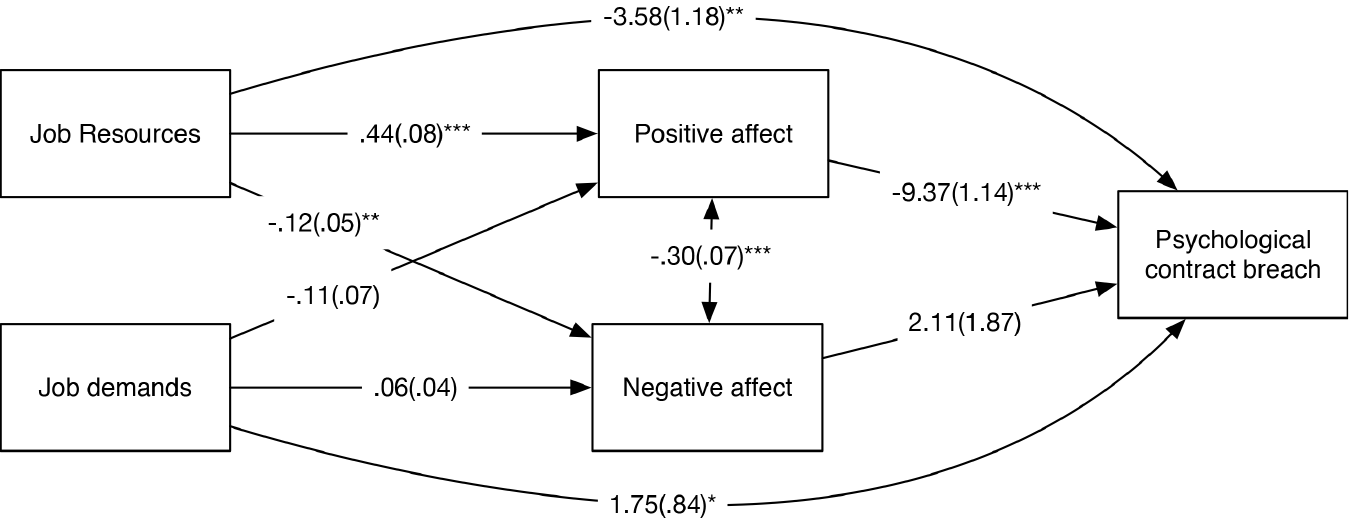
Fig 1. Path estimates from model with concurrent relationships in Study 1. * : p < .05, ** : p < .01, *** : p < .001. Standard errors between parentheses.